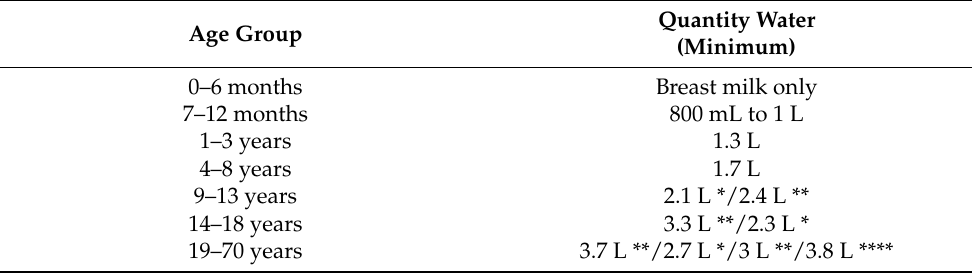
Table 1. Minimum water consumption by age group.